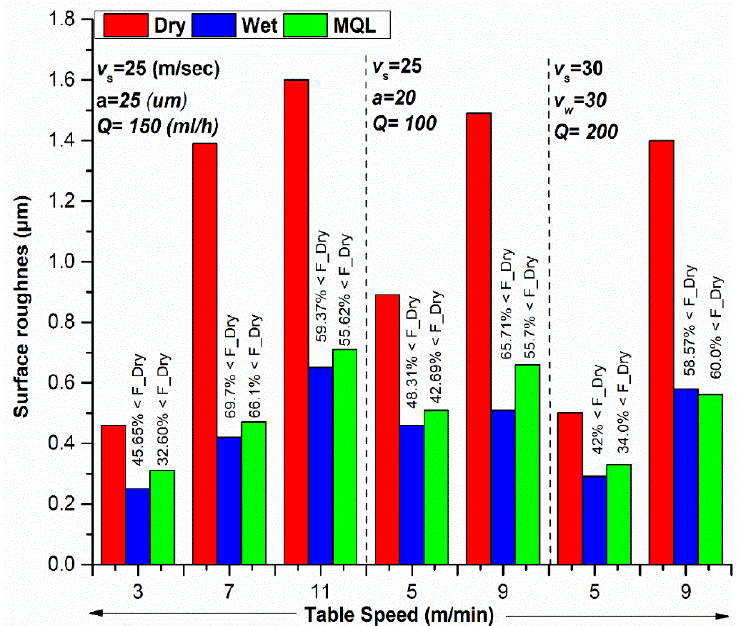
Figure 7. Comparison of surface roughness in different cooling environments.